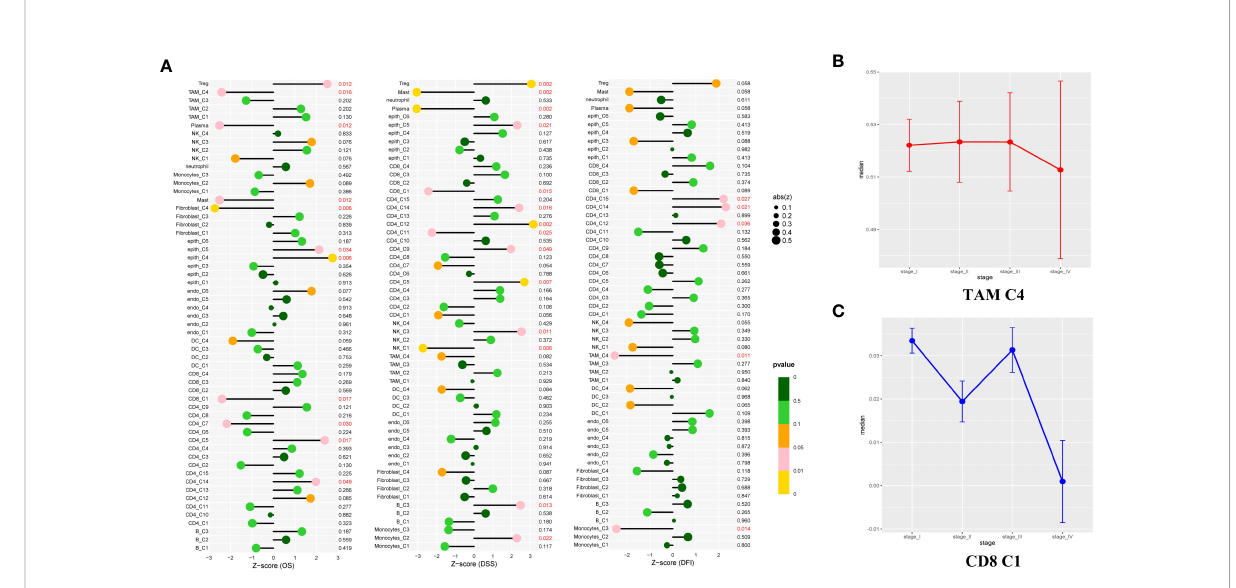
FIGURE 6 Study of the prognostic effect in the TCGA cohort. (A) The lollipop plot showed the correlation between the different cell clusters and disease- free interval (DFI), disease-speci fi c survival (DSS), or overall survival (OS). The risk was measured in Z score with a Cox regression model. The clusters with better outcomes (p < 0.05). (B, C) Line charts showed TAM C4 and CD8 C1 enriched in early-stage LUAD tissues, but showed opposite properties in the late-stage. Measured with the one-way ANOVA